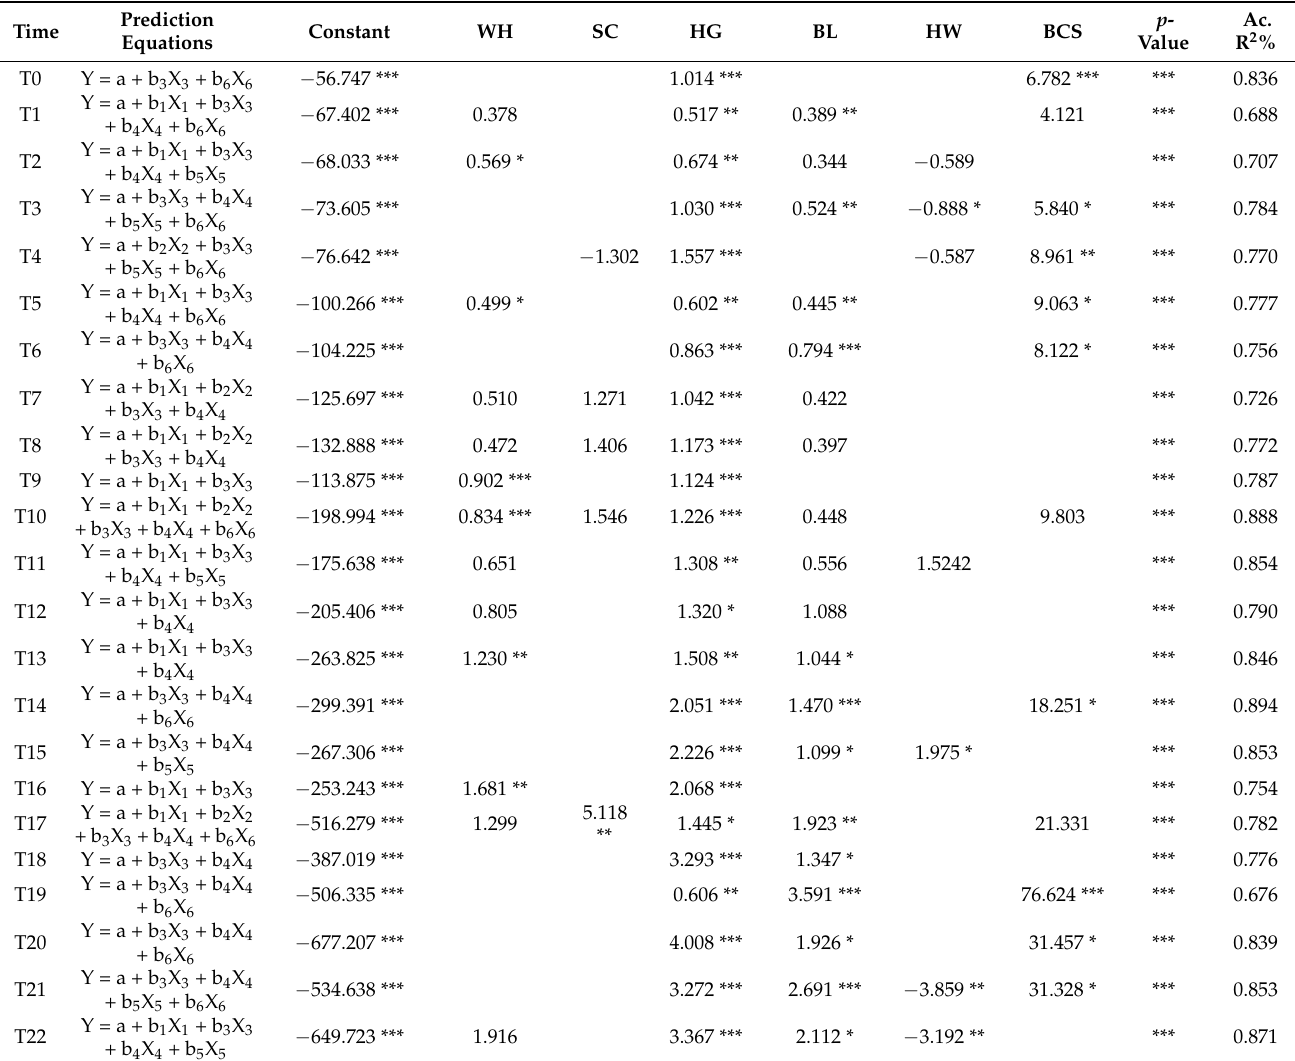
Table 2. Prediction equations of BW and linear effects of selected BMs evaluated in 25 rearing Holstein heifers at different times (T0–T22).